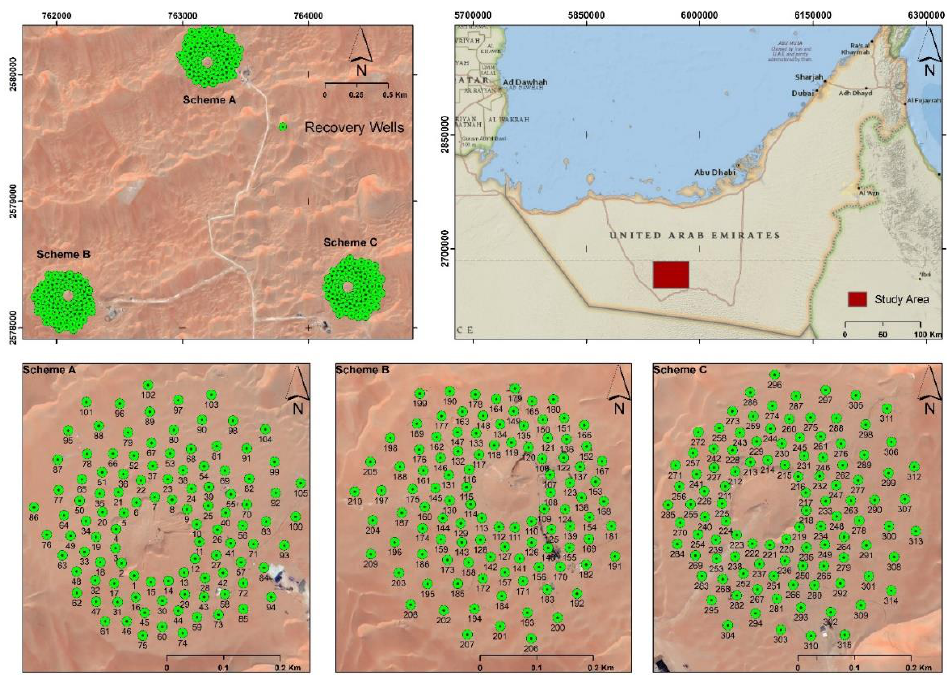
Figure 2. The Strategic Water Storage and Recovery Project. Recovery well locations in three Schemes A, B, and C.